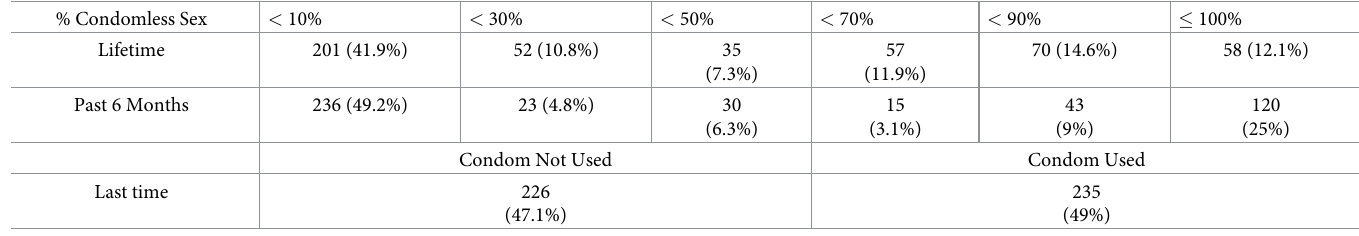
reported that they were attracted to both men and women and 2 (0.4%) reported that they were not attracted to either men or women. Two hundred and thirty-five (49%) participants were single, 227 (47.3%) were in an exclusive relationship, 7 (1.5%) were in an open relation- ship, 2 (0.4%) were married and 5 (1%) chose ‘other’. One participant (0.2%) reported cur- rently having an STI, and 20 (4.2%) participants reported having had an STI in the past. The majority of participants (89%) reported at least one sexual partner. Of these, the median num- ber of lifetime sexual partners was 2 (min = 1, max = 30) and the median age at first sexual intercourse was 17 years old (min = 12, max = 23). Twenty-one (4.4%) participants reported an allergy to latex, non-latex condoms and/or lubricants. Reported rates of condomless sexual intercourse are presented in Table 2. Condom resistance tactics. Half of the women (n = 240) reported using at least one tactic. The four most frequently reported condom resistance tactics were the following: “Getting him really aroused and then starting to have sex without a condom” ( n = 129), “Getting him so sex- ually excited that he agreed to have sex without a condom” ( n = 80), “Reassuring him that you